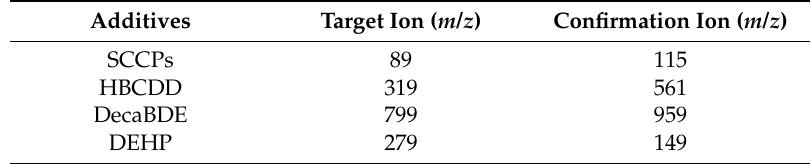
Figure 2. ( a ) Comparison of calibration curves of individual ion signals for SCCPs analysis. Area represents the average of three repeated measurements; ( b ) Overlapping noise levels of various polymer materials. PE: polyethylene, PS: polystyrene, PP: polypropylene, PVC: polyvinyl chloride. Table 1. Target ions used for the quantification of simultaneous screening by